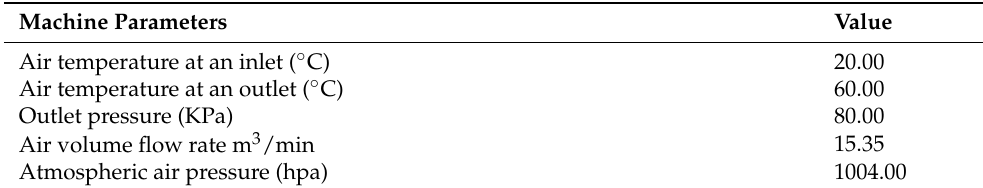
Table 13. Experimental cooling air parameters.